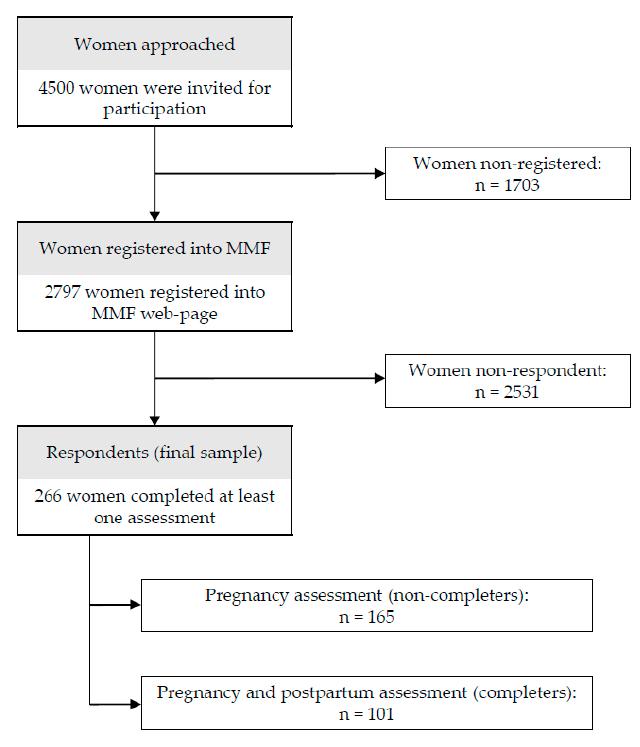
Figure 1. Flow diagram of participants.